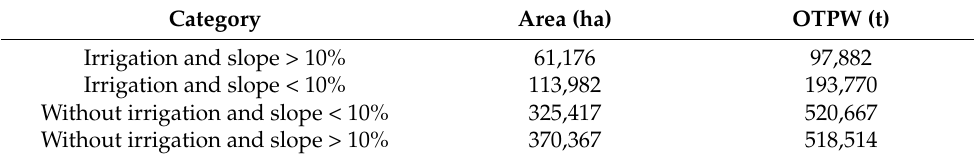
Table 2. Availability of olive tree pruning waste (OTPW) depending on the cultivation category. Category Area (ha) OTPW (t) Irrigation and slope > 10% 61,176 97,882 Irrigation and slope < 10% 113,982 193,770 Without irrigation and slope < 10% 325,417 520,667 Without irrigation and slope > 10% 370,367 518,514